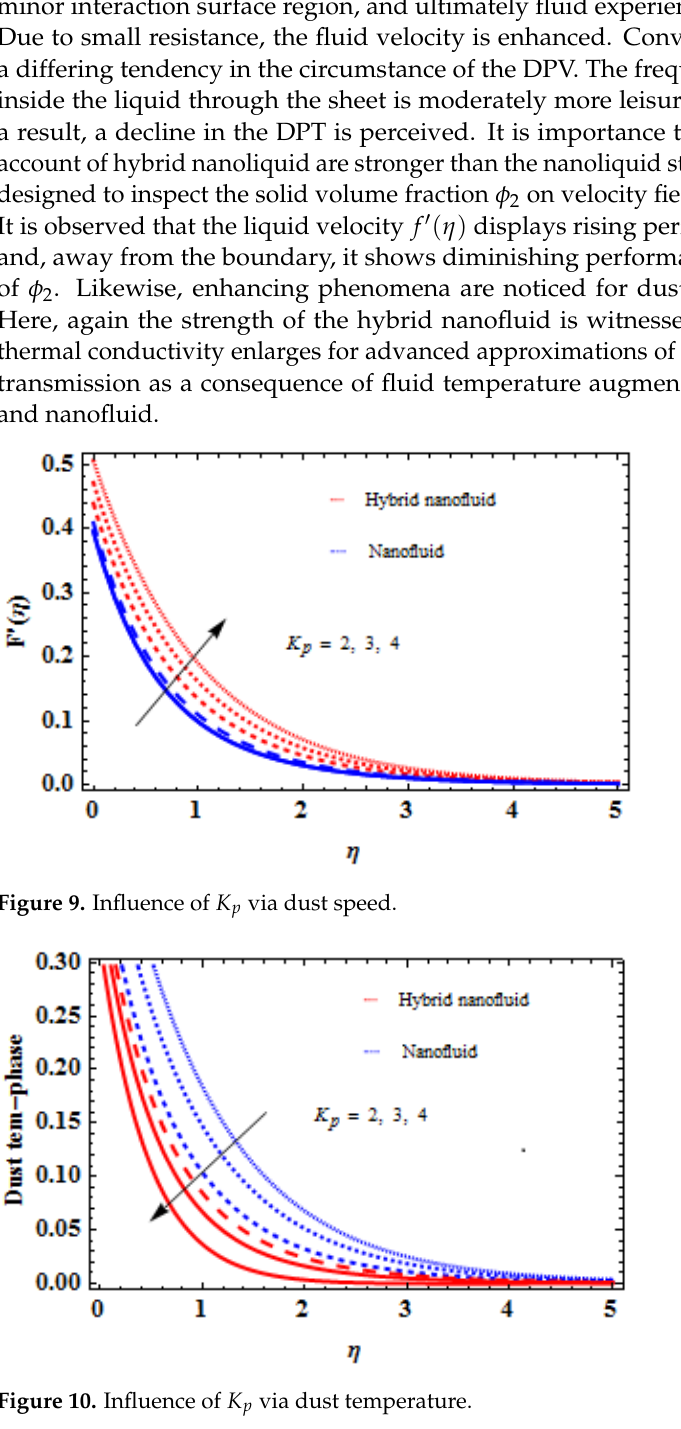
Figure 11. Influence of 𝜙 2 via velocity field. Figure 12. Influence of 𝜙 2 via dust velocity.